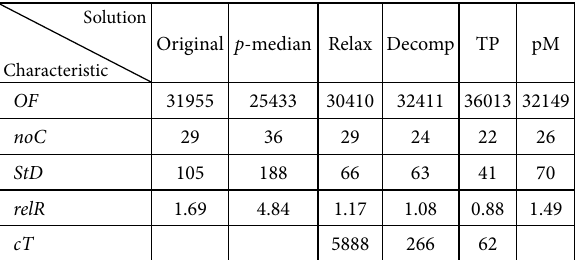
Table 7. Comparison of the results for the region ZA